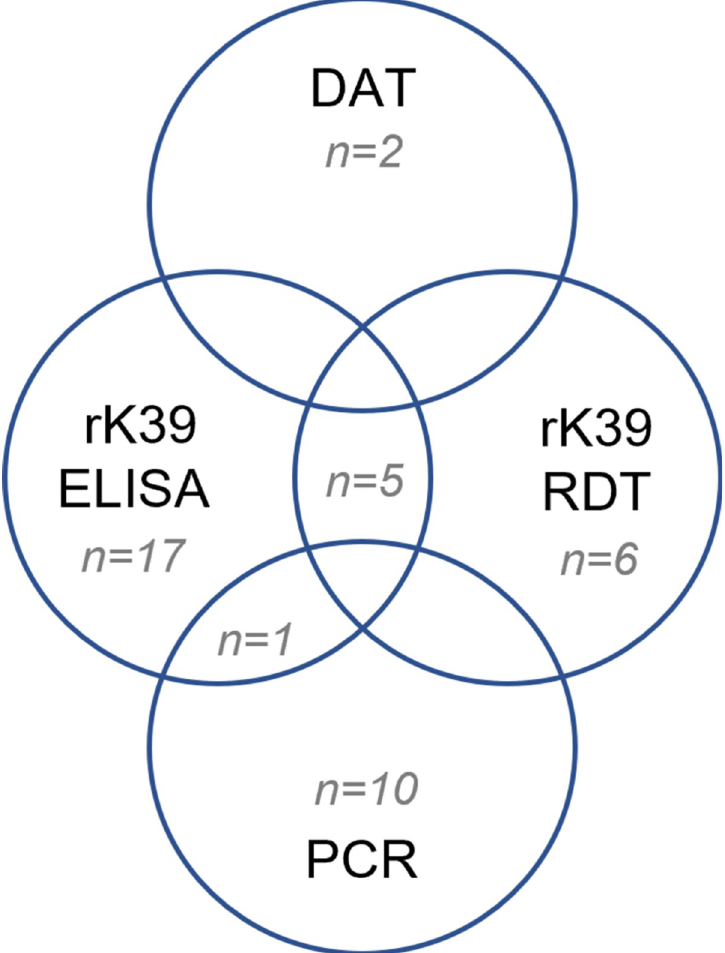
Fig 1. Venn diagram with the results of the different tests to detect asymptomatic Leishmania infection. DAT: direct agglutination test; ELISA: Enzyme-linked immunosorbent assay; PCR: polymerase chain reaction; RDT: rapid diagnostic